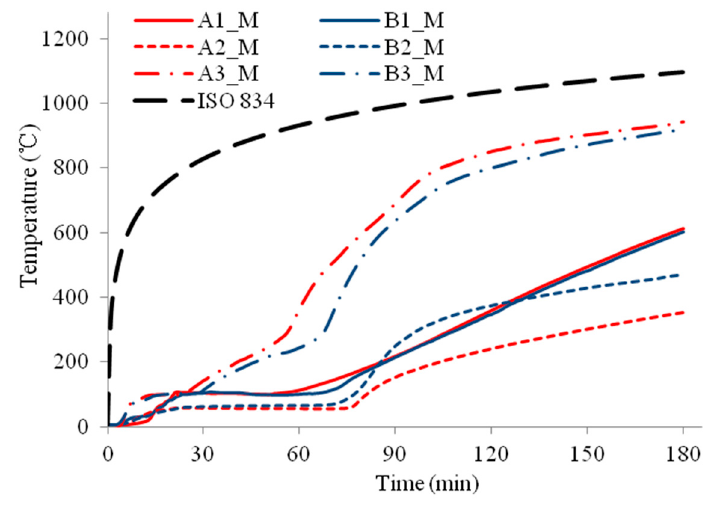
Figure 10. Temperature profiles at the top section for HSS-C1.